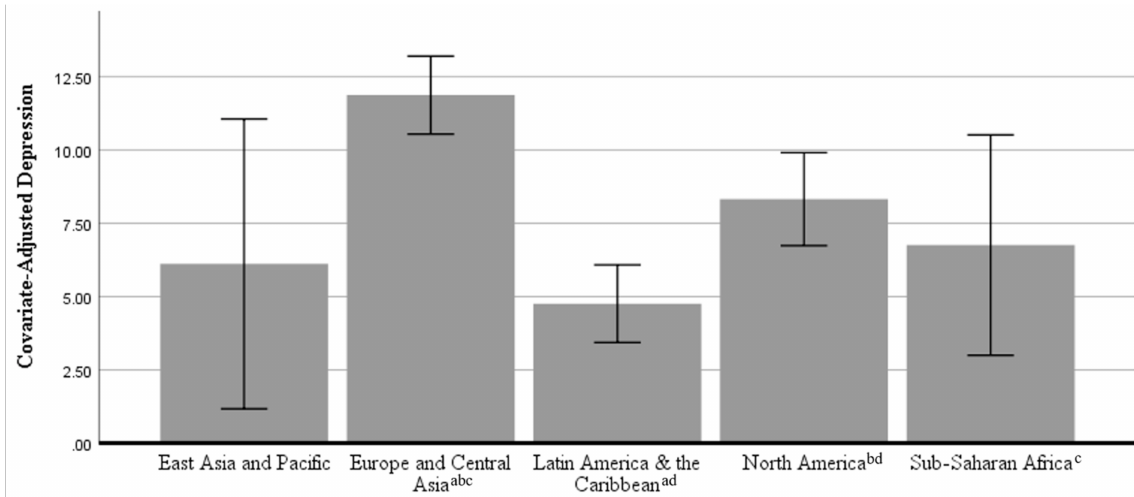
Figure 2. Covariate-Adjusted Depression Scores (Mean with 95% Confidence Intervals) by Global Region. Note: Means were adjusted for the following covariates: gender, age, country income classification, marital status, work status, and having dependents in the home. Regions sharing the same superscript were significantly different at p < 0.05 after Bonferroni